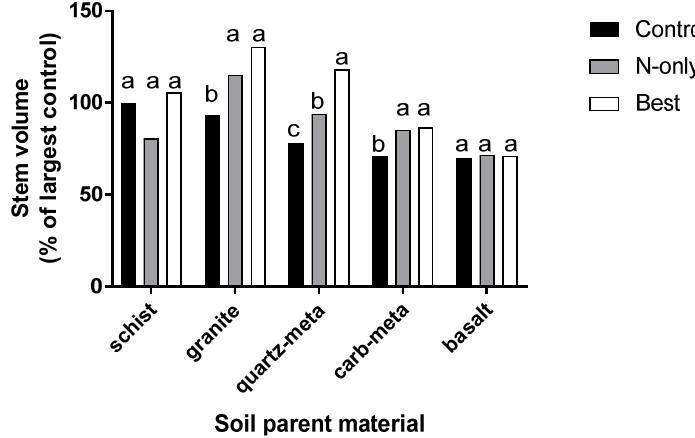
Figure 8. Fertilizer treatment effects on 2-year stem volume by soil parent material. Stem volume is expressed as a percentage of untreated trees growing on schist soils. Fertilizer treatments included 224 kg N ha − 1 (N-only), or a blend of 224 kg N ha − 1 , 190 kg K ha − 1 + 73 kg S ha − 1 + 2.7 kg B ha − 1 (Best). Two metasedimentary parent materials include a quartzite (quartz-meta) and carbonate (carb-meta) [24].